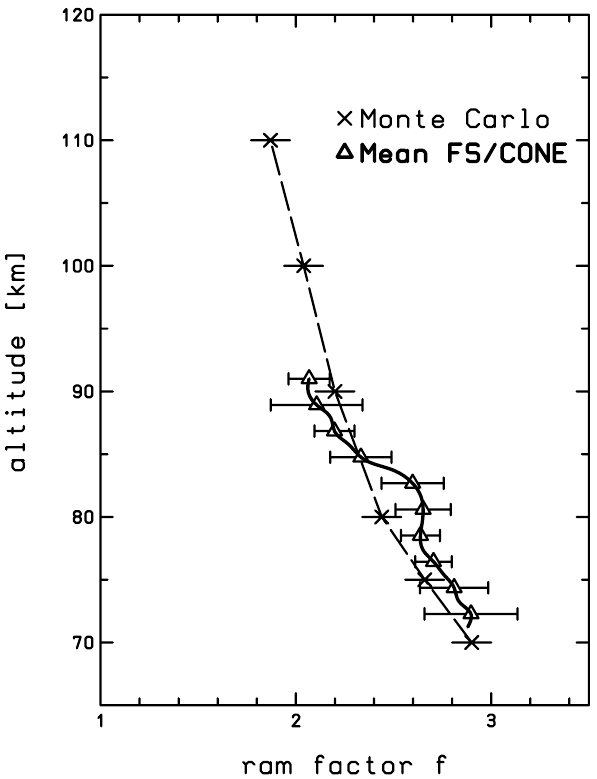
Fig. 6. Altitude profiles of ram-factors for the CONE instrument once determined numerically with DSMC calculations (dashed line) and once determined from the comparison of CONE and falling sphere measurements (thick solid line). Error bars of the DSMC data represent the statistical uncertainty of the simulations; those of the CONE/falling sphere data represent the rms variation of the seven individual